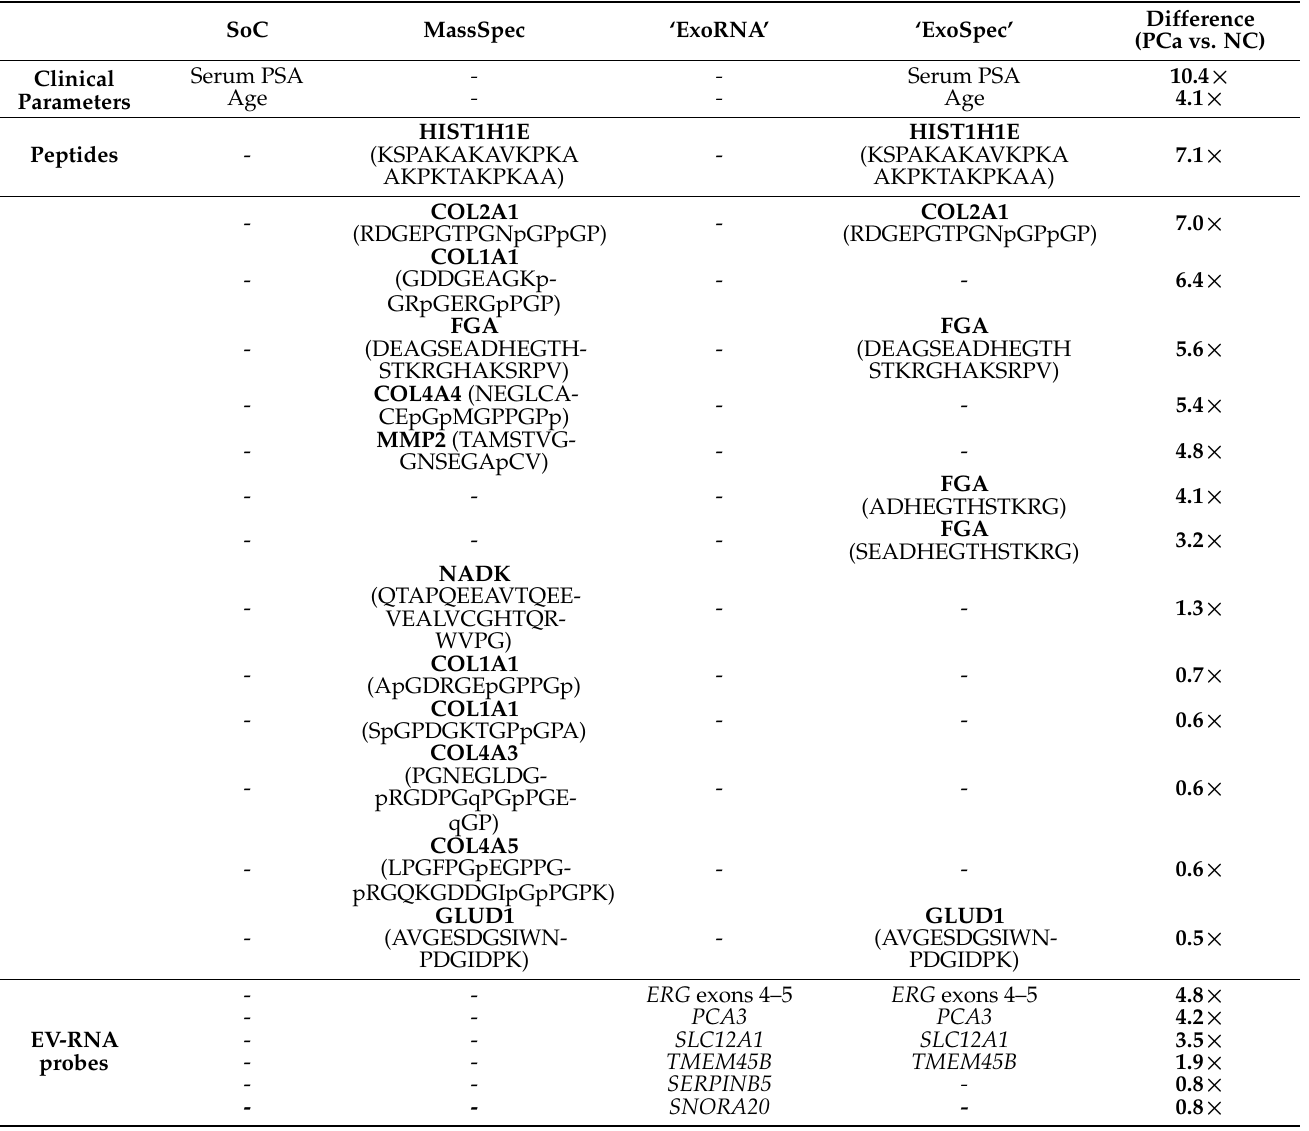
Table 2. Features positively selected for each